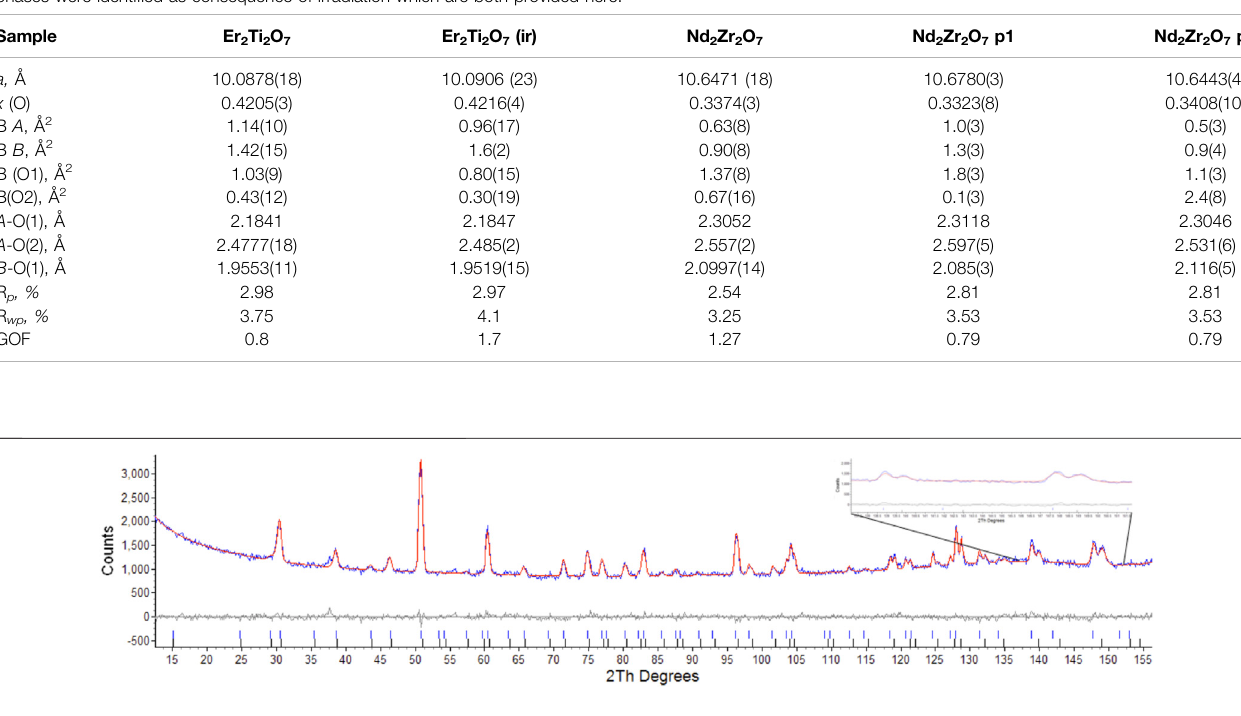
TABLE 2 | Re fi ned parameters for neutron data. Where a isthe lattice parameter, x (O) isthe value of the 48f site, B A isthe overall isotropic displacement parameter ofthe A cation , B B istheoverallisotropicdisplacementparameterofthe B cation , B(O1)istheoverallisotropicdisplacementparameteroftheoxygenattheO1position,B(O2)is the overall isotropic displacement parameter of the oxygen at the O2 position, A -O(1) is the distance between the A cation and the oxygen at the O1 position, A -O(2) is the distancebetweentheAcationandtheoxygenattheO2position, B -O(1)isthedistancebetweentheBcationandtheoxygenattheO1position, ε 0isthecalculatedstrain,R p istheR-pattern(backgroundcorrected) , R wp istheR-weightedpattern(backgroundcorrected) , andGOFisthegoodnessof fi t.Forthezirconatesampletwopyrochlore phases were identi fi ed as consequence of irradiation which are both provided here.